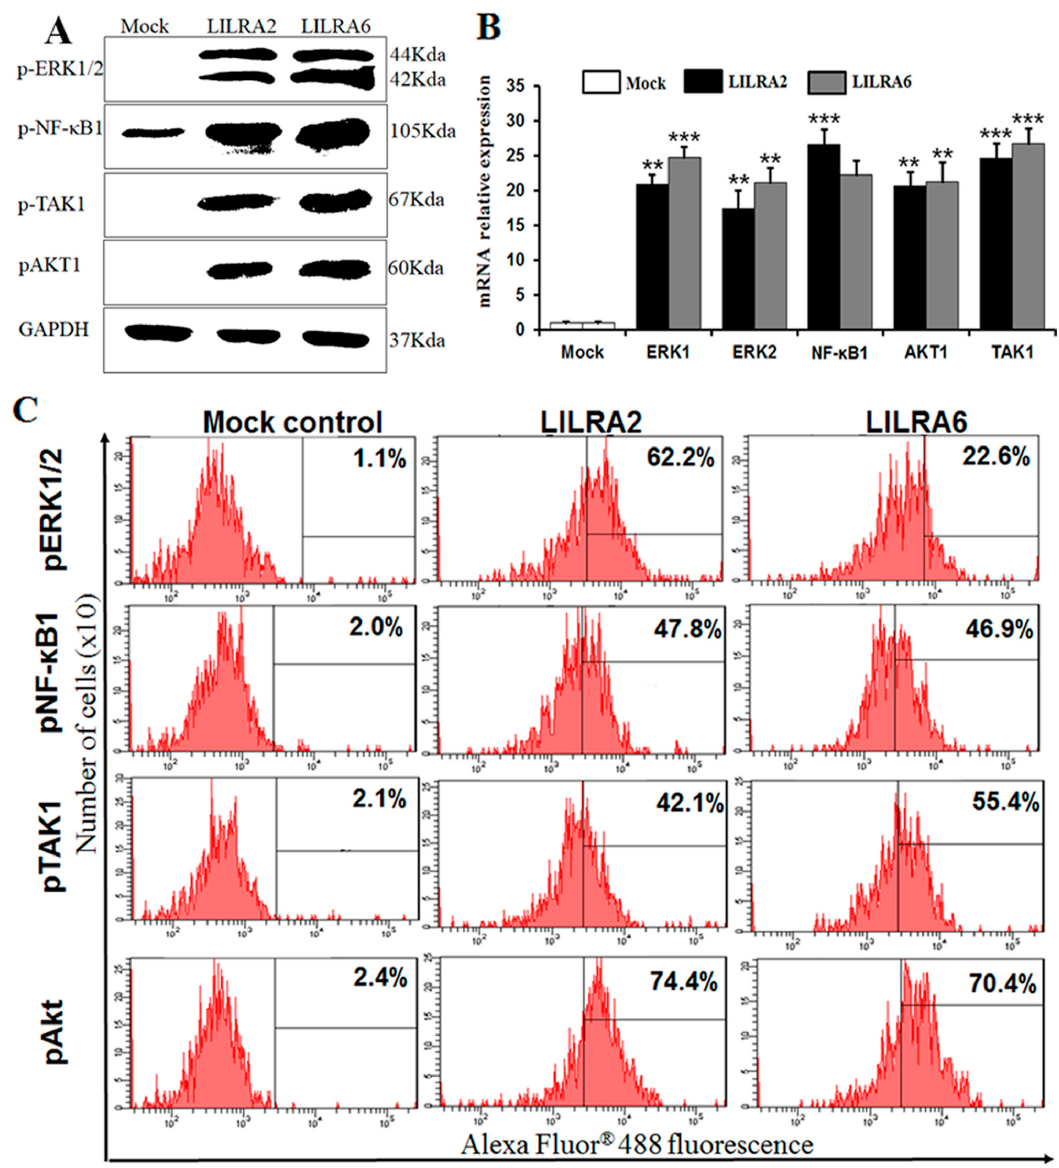
Figure 6. NF- κ B and MAPK signaling pathways regulated by LILRA2 and LILRA6. Western blot ( A ) and FACS ( C ) analyses for phosphorylated ERK1/2, NF- κ B1, TAK1 and AKT1 in LILRA2 and LILRA6 transfected HD11 cells; ( B ) qRT-PCR expression of ERK1, ERK2, NF- κ B1, TAK1 and AKT1 in LILRA2 and LILRA6 transfected HD11 cells. Data are presented as the mean ± SEM of three independent experiments: ** p < 0.01 and *** p < 0.001.